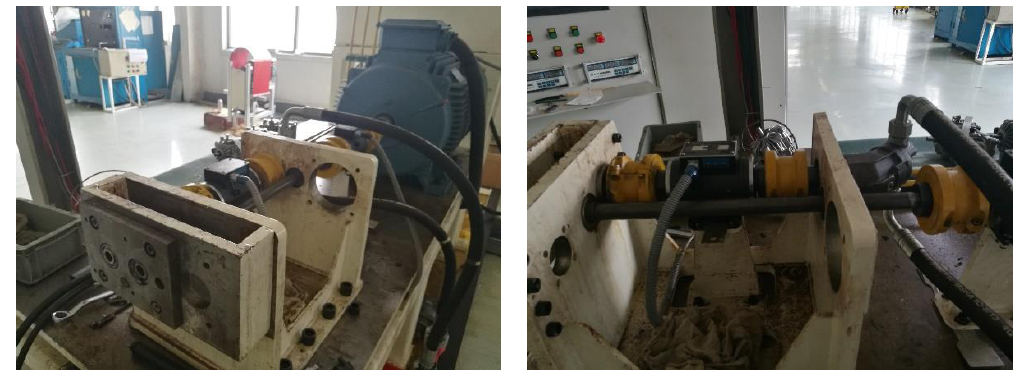
Figure 17. Hydrostatic CVT efficiency test bed.